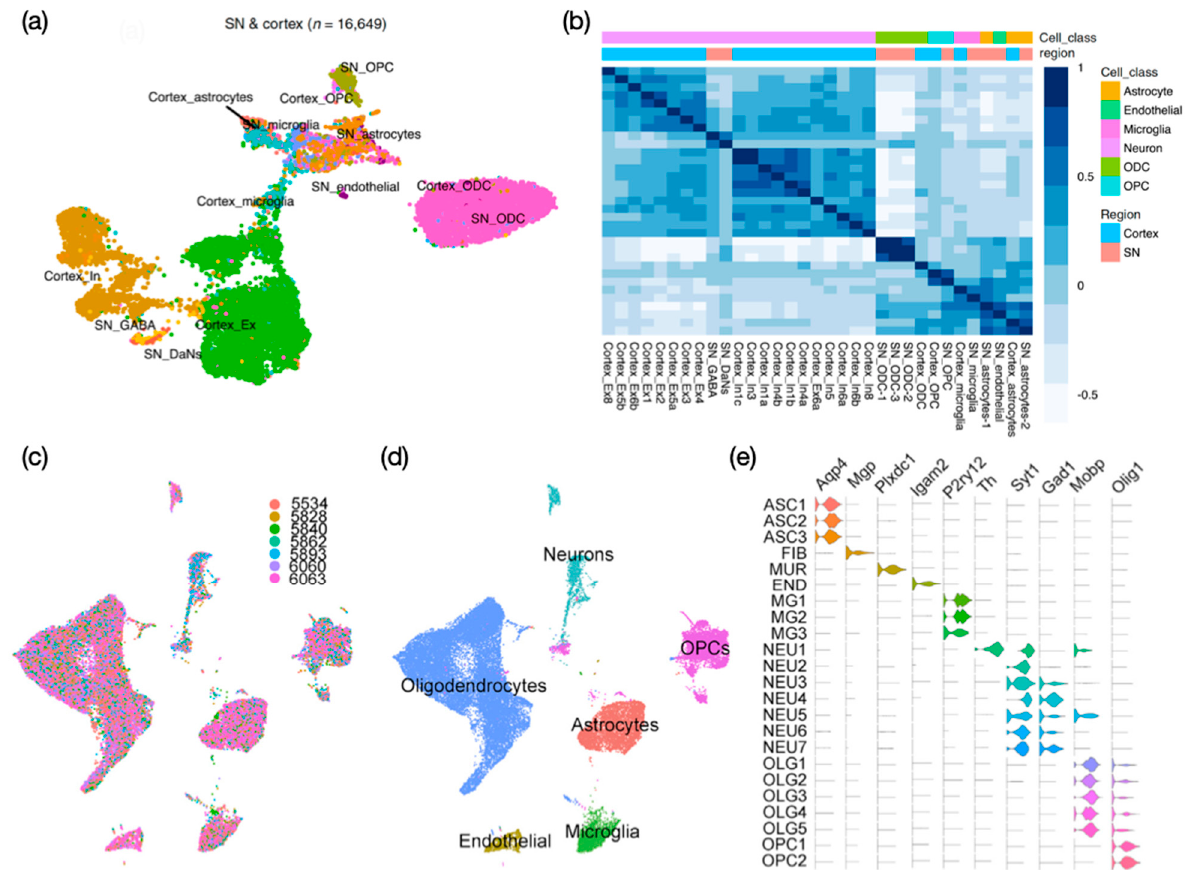
Figure 3. The snRNA-seq of human postmortem brain tissues in studies of PD. ( a , b ) Use of SN and cortex tissues derived from five healthy individuals. Reprinted from [30] , Copyright 2020, Devika Agarwal et al. ( a ) UMAP (colored by cell type) and ( b ) correlation heatmap depicting hierarchical clustering with Pearson correlation as distance metric. ( c – e ) Use of SN tissues derived from seven healthy individuals. Reprinted from [32] , Copyright 2019, with permission from Elsevier. UMAP plots colored by ( c ) donor and ( d ) cell type. ( e ) Violin plots depicting expression of PD-related genes across the identified cell types.